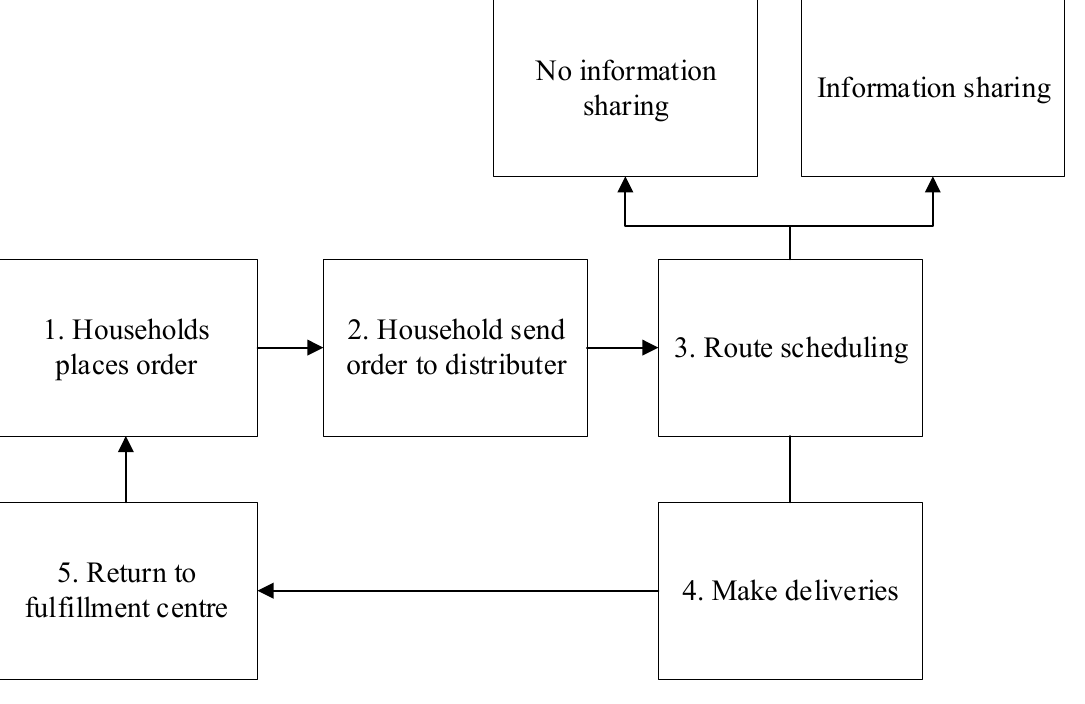
Figure 2. The model